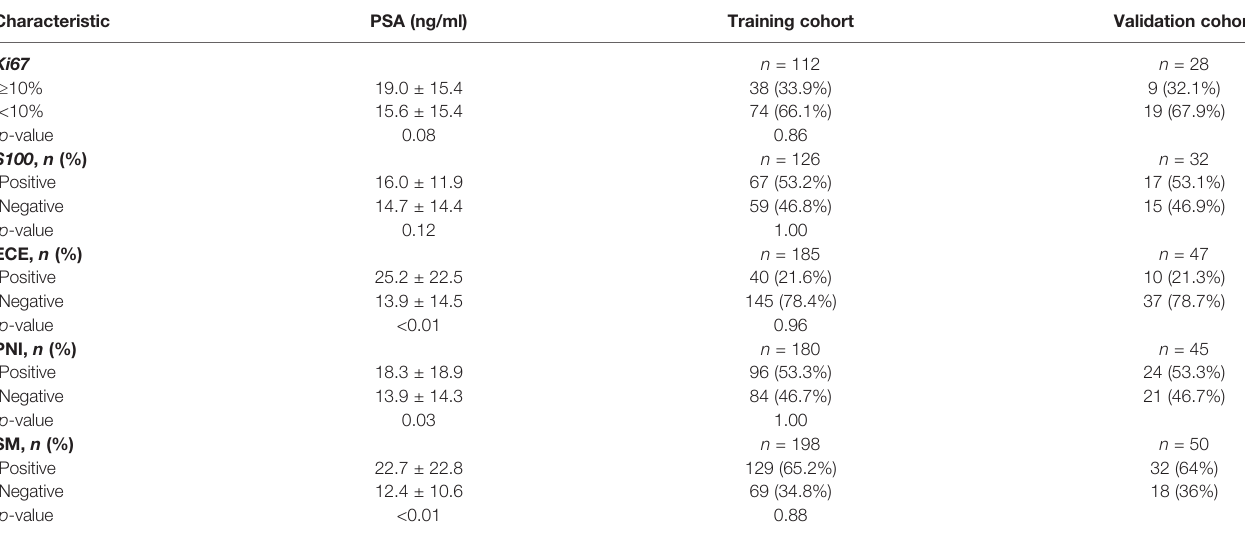
TABLE 1 | Patient pro fi les of each